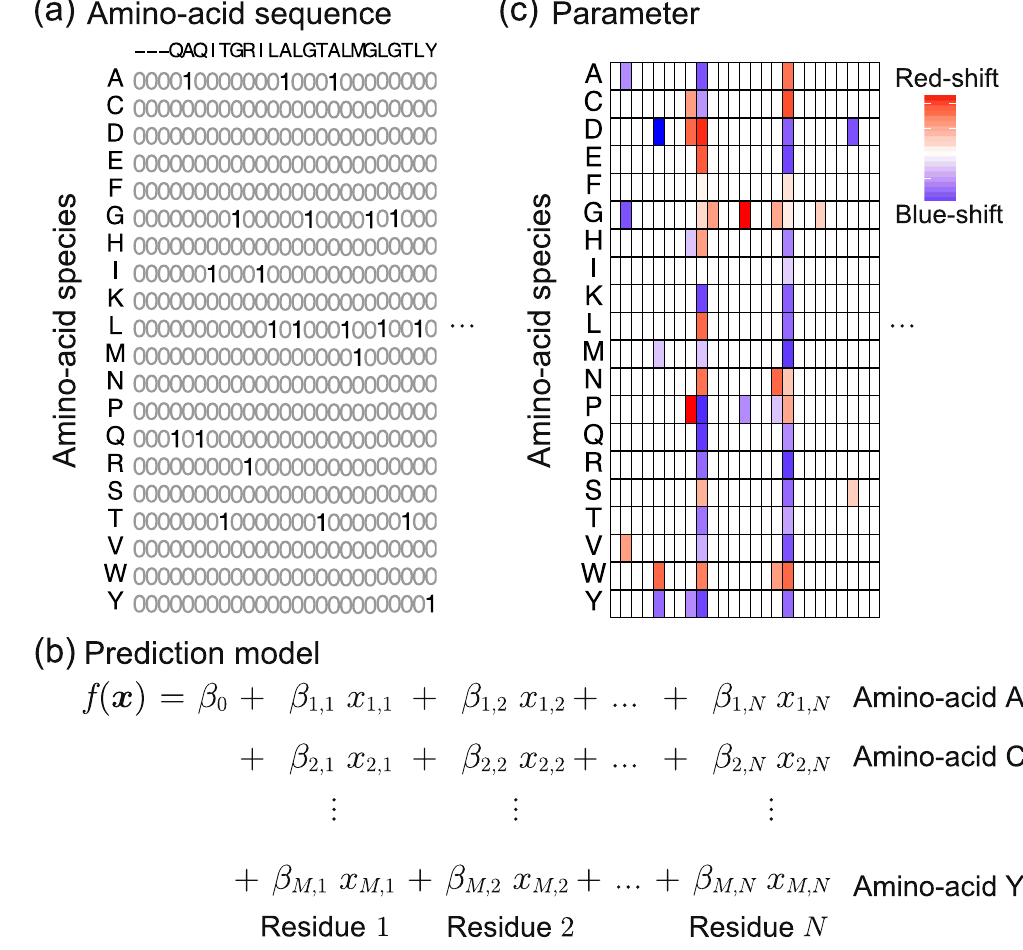
Figure 4. A schematic description of the ML method introduced in the present paper for functional protein studies. ( a ) Binary sequence representation of an amino-acid sequence. Let M = 20 be the number of amino- acid species, and let N be the number of residues considered in the present study. Then, the amino-acid sequence of a protein is represented by M × N binary variables, each of which represents the amino-acid species at each residue. ( b ) By writing the MN binary variables as x i , j , i = 1, … , M , j = 1, … , N , we consider an MN - dimensional linear model. The linear model has an intercept parameter β 0 and MN coefficient parameters β i , j , i = 1, … , M , j = 1, … , N . ( c ) When the linear model is fitted, a group-wise sparsity constraint is introduced. Then, in many residues, all of the corresponding M coefficients would be fitted to zero, and only a small number of residues have nonzero coefficient parameters. The latter residues are called active residues . The choice of amino-acid species in these active residues is expected to play an important role in determining molecular properties such as absorption wavelength.